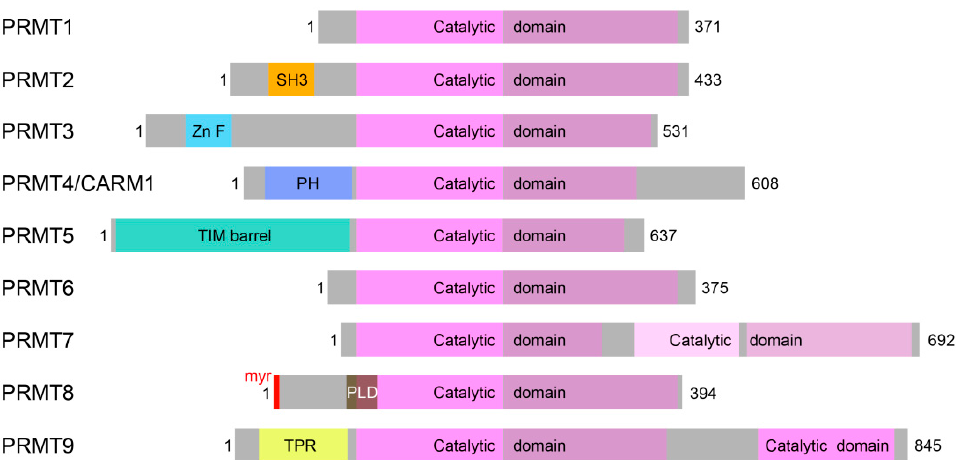
Figure 2. The family of human PRMTs. The catalytic core of PRMT1–9 is represented by the catalytic Rossman fold also known from other methyltransferases, such as protein lysine, DNA or RNA methyltransferases (light purple), as well as by the so-called β -barrel, which is involved in substrate recognition and PRMT dimerization (darker purple). In lighter shades are the less well studied C-terminal parts of PRMT7, with similarity to structural elements of the catalytic cores of other PRMTs, but without detected binding of the methyl donor S-adenosylmethionine. [10]. Other colors highlight additional domains found in the nine different PRMTs: orange, Src Homology 3 (SH3) domain of PRMT2; light blue, zinc finger (Zn F) of PRMT3; darker blue, Pleckstrin Homology (PH) domain of PRMT4/CARM1; turquoise, TIM barrel of PRMT5; red, N-terminal myristoylation (myr) site of PRMT8; yellow, tetratricopeptide repeats (TPR) of PRMT9. The region responsible for the additional phospholipase D activity (PLD) of PRMT8 is represented by a brown, transparent box, as it overlaps with the catalytic domain for arginine methylation.